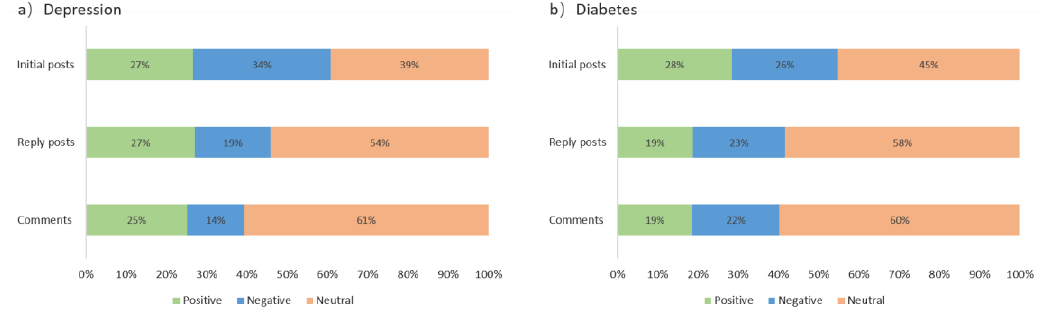
Figure 6. Proportion of text sentiment in online ( a ) depression and ( b ) diabetes communities.